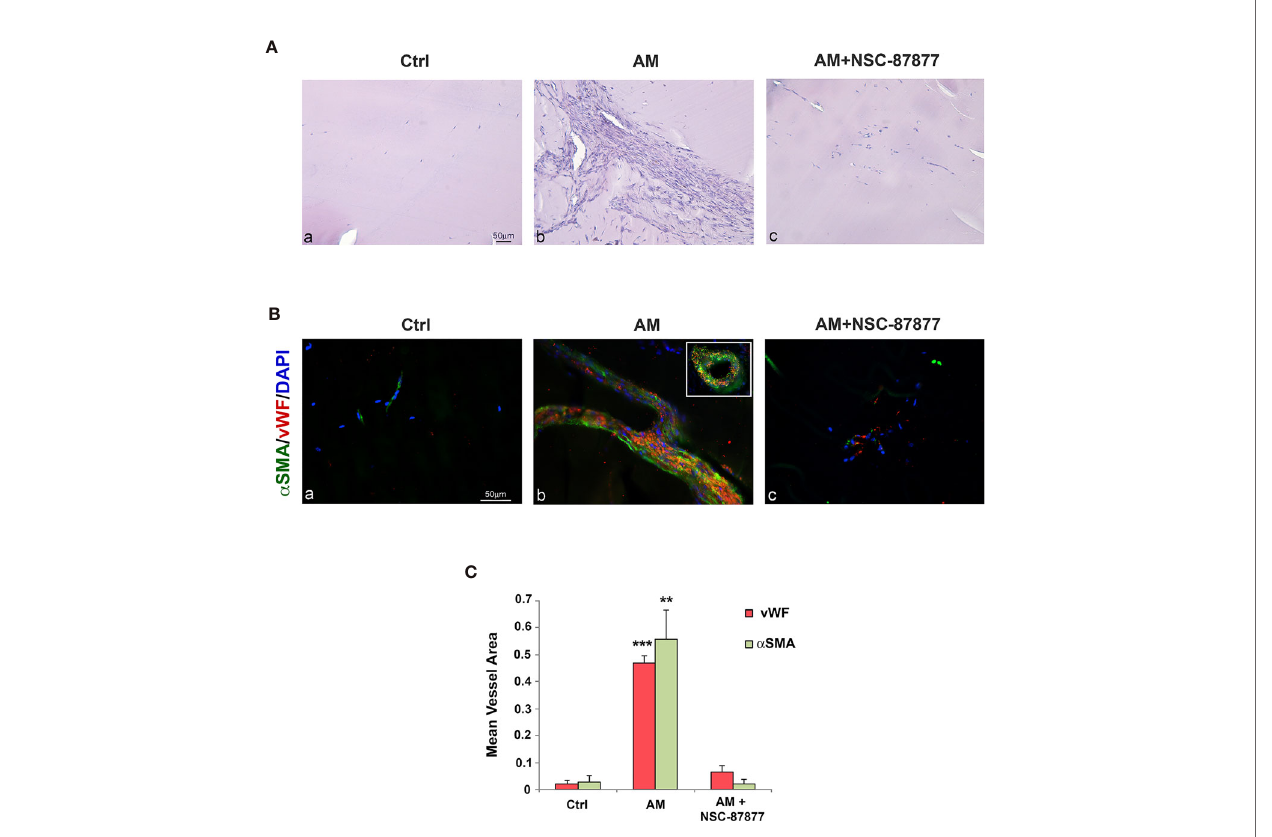
FIGURE 7 | Inhibition of SHP-2 impairs AM-induced angiogenesis into Matrigel plugs in vivo . (A) C57BL/6 mice were injected s.c. at the abdominal midline with 0.8 ml of growth factor-depleted Matrigel without adding growth factor (Ctrl; a ) or containing AM (2 m g/ml; b ) or AM (2 m g/ml) in presence of NSC-87877 (30 m M) (c) for 21 days. Microphotographs of histochemical-stained Matrigel sections for H&E are shown. (B) Matrigel plugs were prepared for immunohistochemical analysis. Sections were evaluated by immuno fl uorescence for vWF (red) and a -SMA (green) and demonstrated the presence of vessel structures characterized by strong interactions between endothelial-like cells and pericytes (b) . The inset in “ b ” shows the vessel area found in Matrigel containing AM. The presence of NSC- 87877 impairs the formation of vessel structures despite the presence of AM (c) . Sparse microvessels are observed in control Matrigel (a) . DAPI-stained nuclei are blue. Scale bar, 50 m m. (C) The mean vessel area was measured through a microscope using NIH 1.62 Software for analysis. ** p < 0.01; *** p < 0.001. Each experiment is representative of two (C) independent experiments with fi ve mice each and six images/animal (n = 30 images for each fi eld represented). Results are shown as means ±